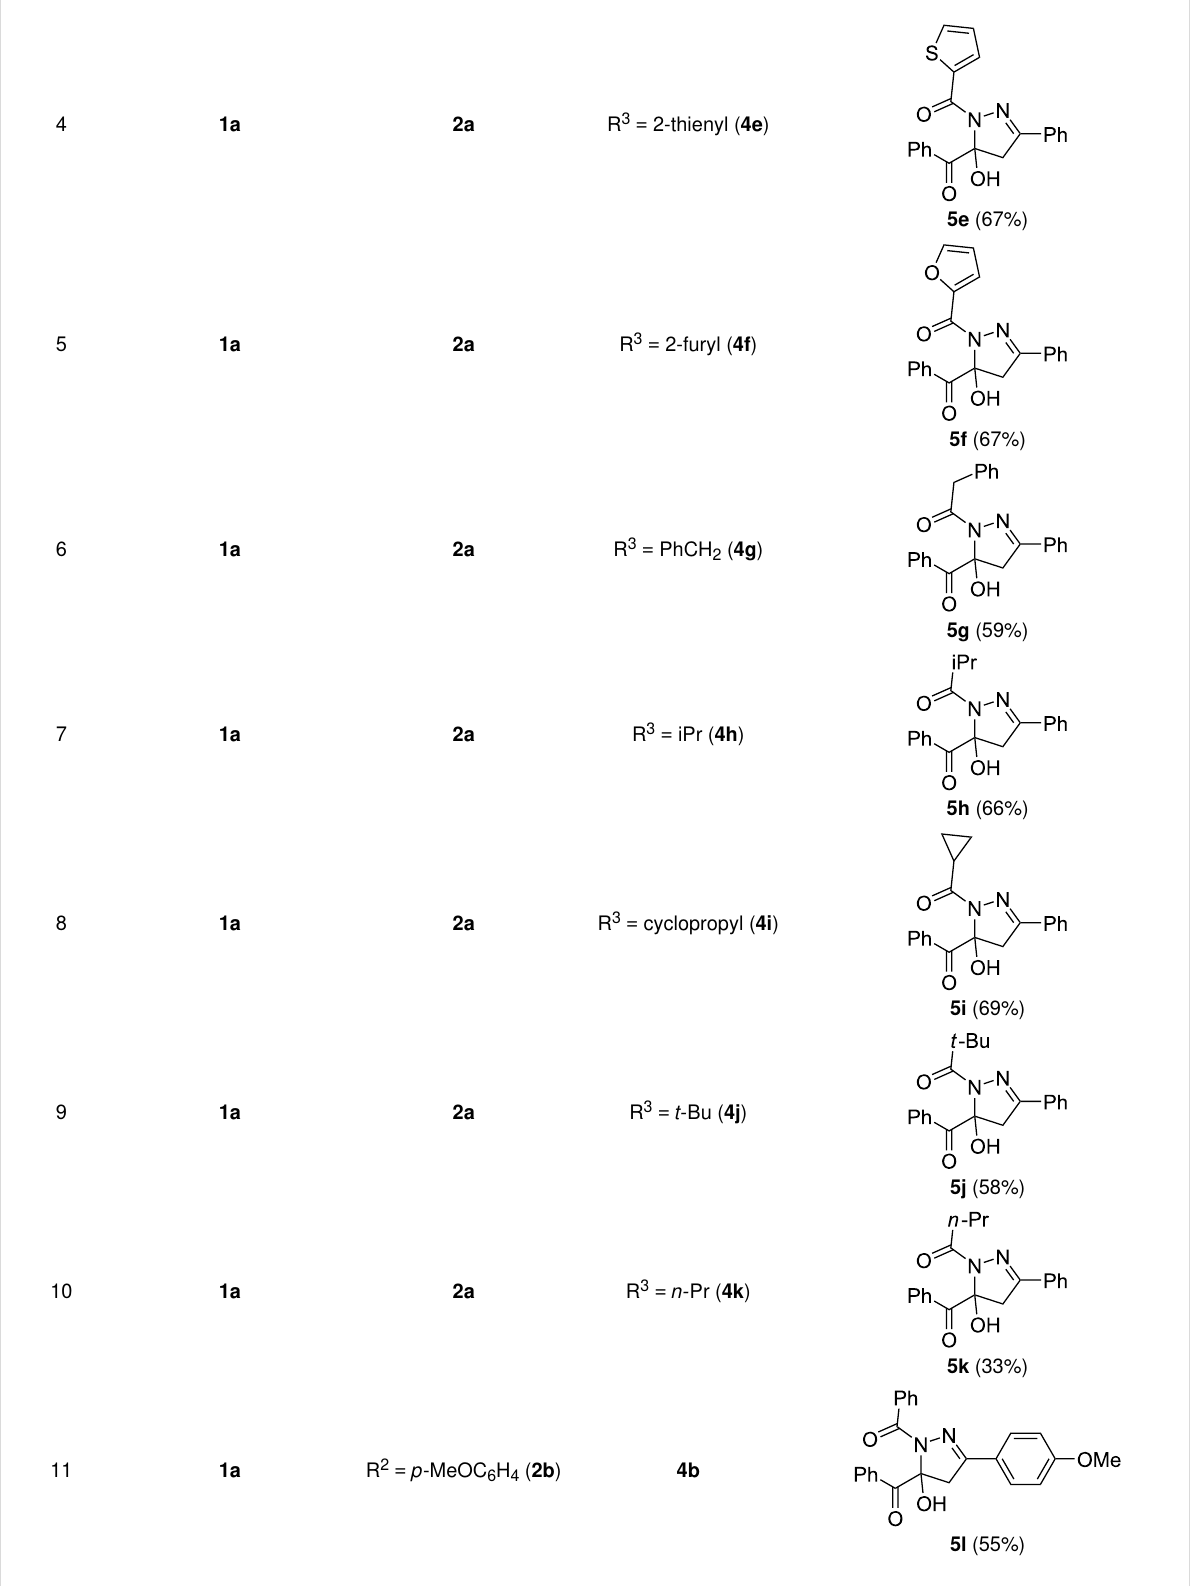
Table 3: Consecutive three-component synthesis of 1,5-diacyl-5-hydroxypyrazolines 5 .